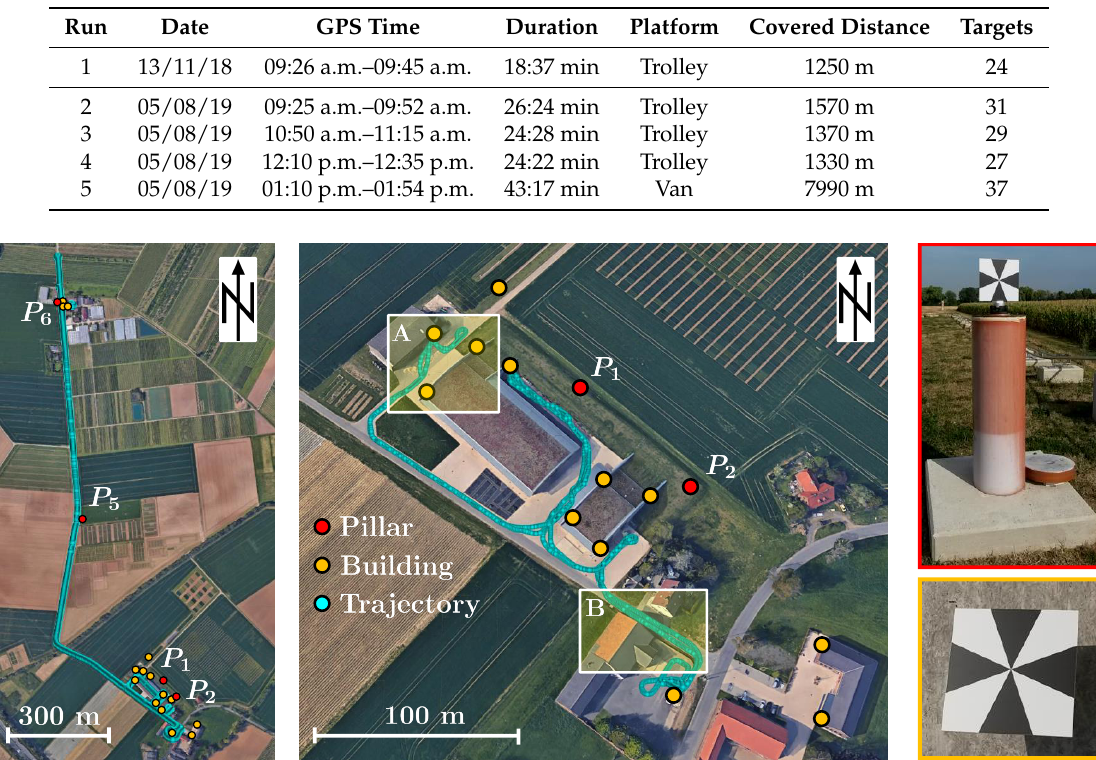
Figure 15. Evaluation of the mobile laser scanning system: Van trajectory ( left ), trolley trajectory ( middle ), control points with BOTA8 targets ( right ). The yellow boxes indicate the test sites A and B for an area-based evaluation of the mobile laser scanning system (Source: Google Earth,